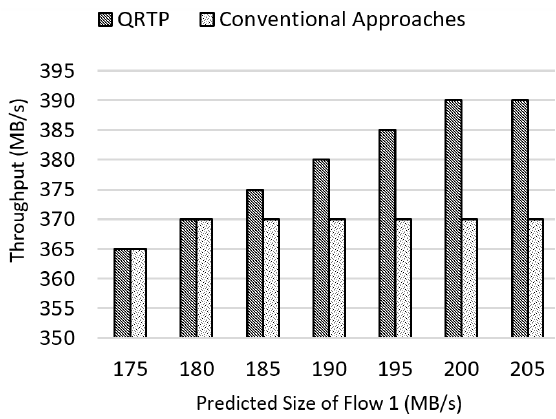
Figure 6. Prediction effect on the link utilization.